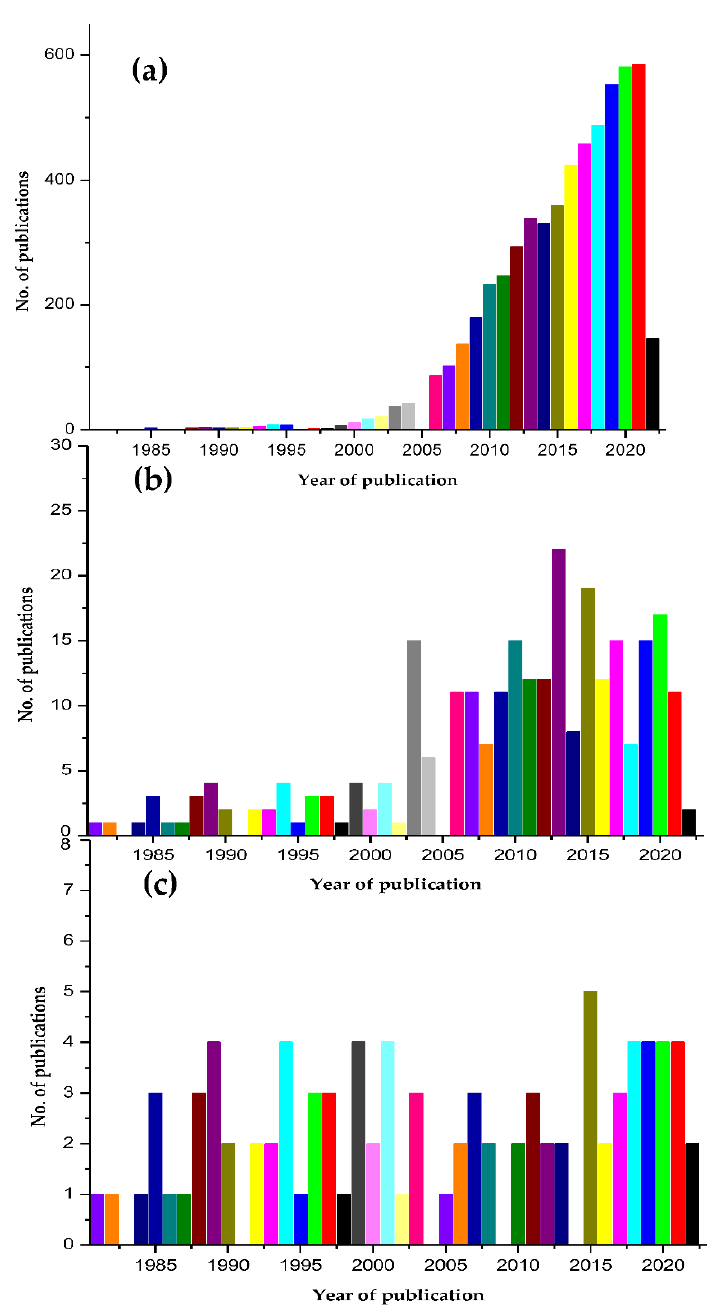
Figure 3. Comparative graph depicting the dearth in publications in the area of chitosan and artificial organs based on a pubmed search during the period of 1981–2022. Graph based on composites and artificial organs based on a pubmed search during the period of 1981 – pubmed search with keywords ( a ) chitosan and tissue engineering ( b ) chitosan and artificial organs 2022. Graph based on pubmed search with keywords ( a ) chitosan and tissue engineering ( c ) chitosan composites and artificial ( b ) chitosan and artificial organs ( c ) chitosan composites and artificial organs.